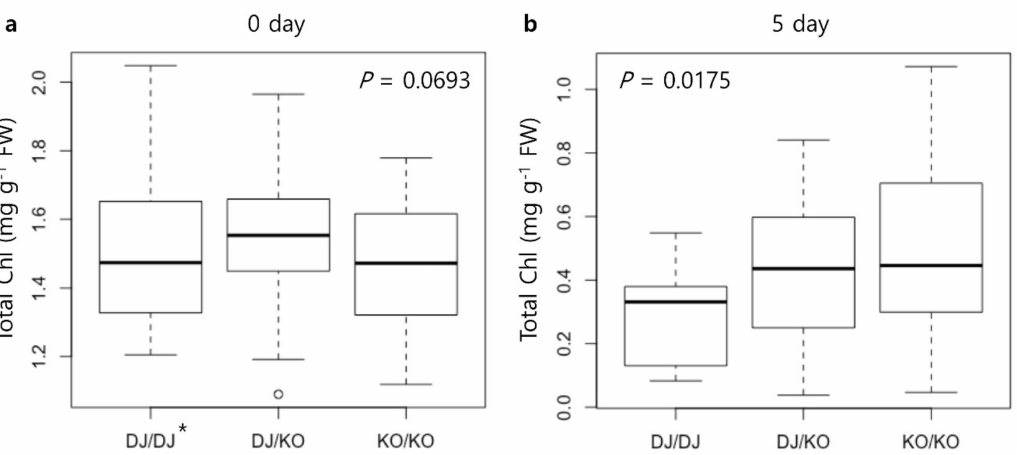
Figure 5. gw2-ko mutant showed delayed senescence. Comparison of ( a ) plant morphology (at 138 days after transplanting) and ( b ) SPAD value ( n = 30) of wild-type Dongjin and gw2-ko . ( c ) Wild type and gw2-ko were grown in a paddy field, and fully expanded flag leaves at the heading stage were used for DIS. ( d , e ) Total chlorophyll contents ( n = 6) and Fv / Fm ratio ( n = 10) were compared between wild type and gw2-ko . Error bars indicate a standard error, and more than six samples were used for each experiment. * and *** indicate significant di ff erence at p < 0.05 and p < 0.001 based on Student’s t -test, respectively.